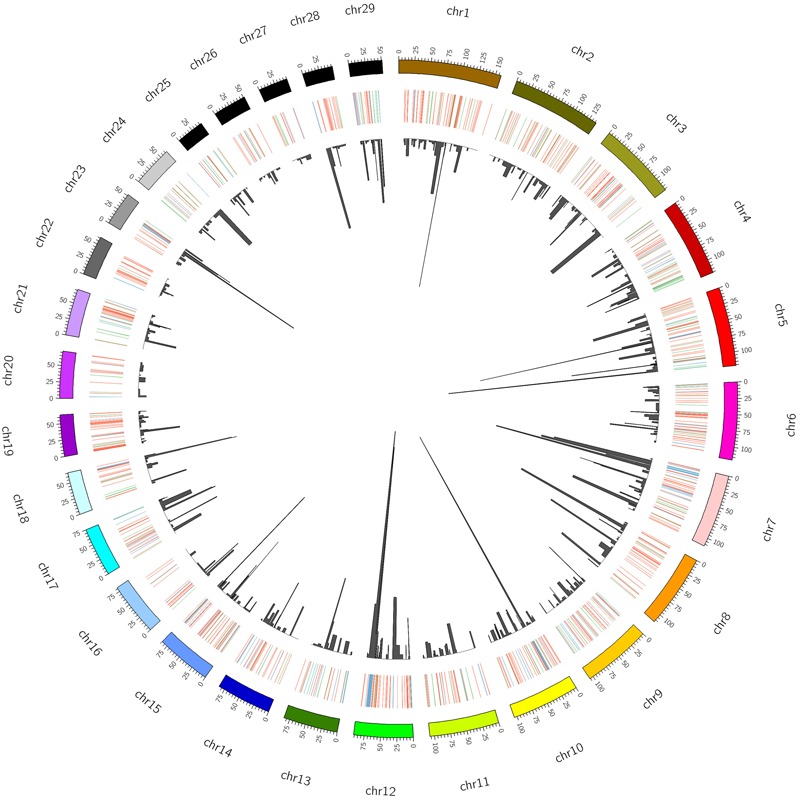
Distribution, status and frequency of CNVR in the bovine genome (UMD 3.1). The status of CNVRs are shown in outer circle in Red (loss), Green (gain) and Blue (both), while the inner circle is indicative of the frequency.